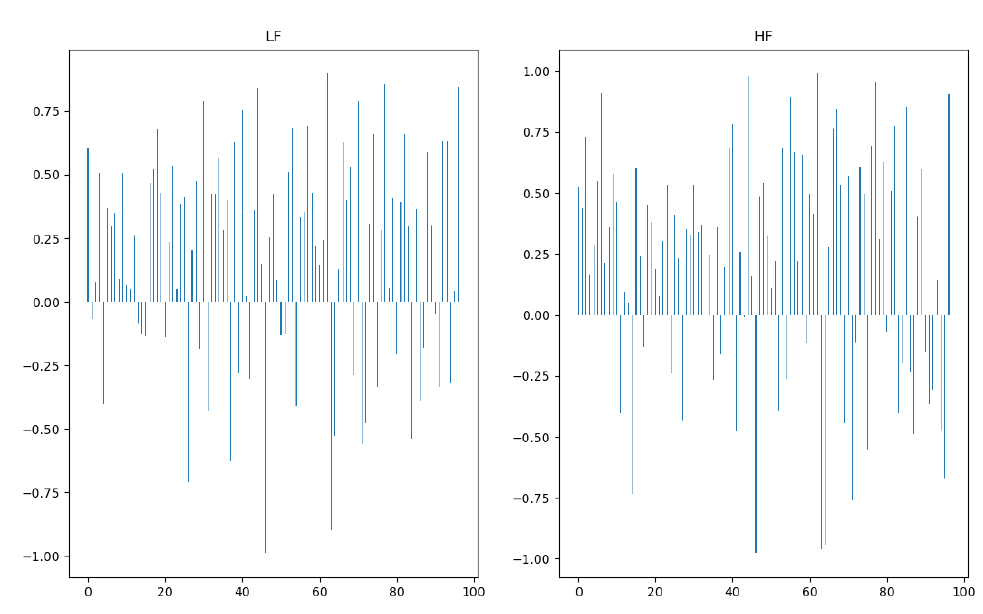
Figure 7. Bar plots of the difference between the normalised values of LF ( left ) and HF ( right ) in the low classification product and the high classification product. The difference in LF and HF was positive for 70% and 69% of this set of 97 experiments, respectively.